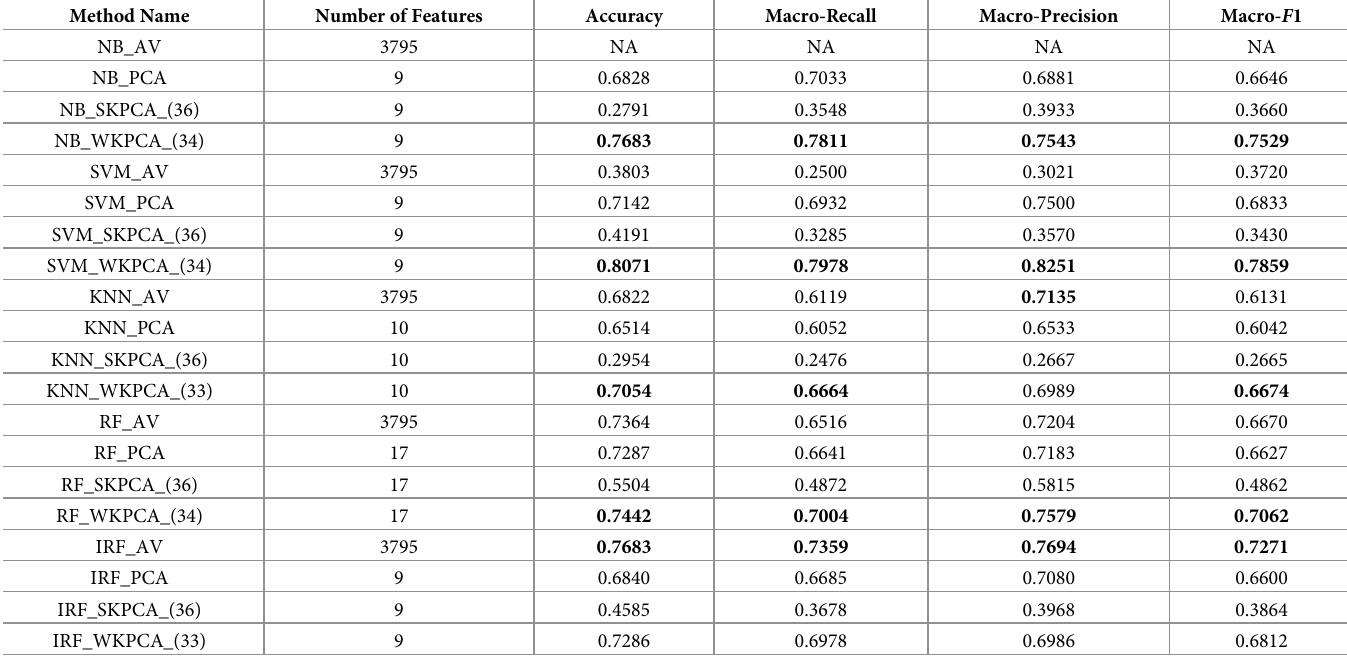
Table 5. Performance measurement comparisons of machine learning methods based on the DLBCL-D data set after WKPCA dimension reduction.